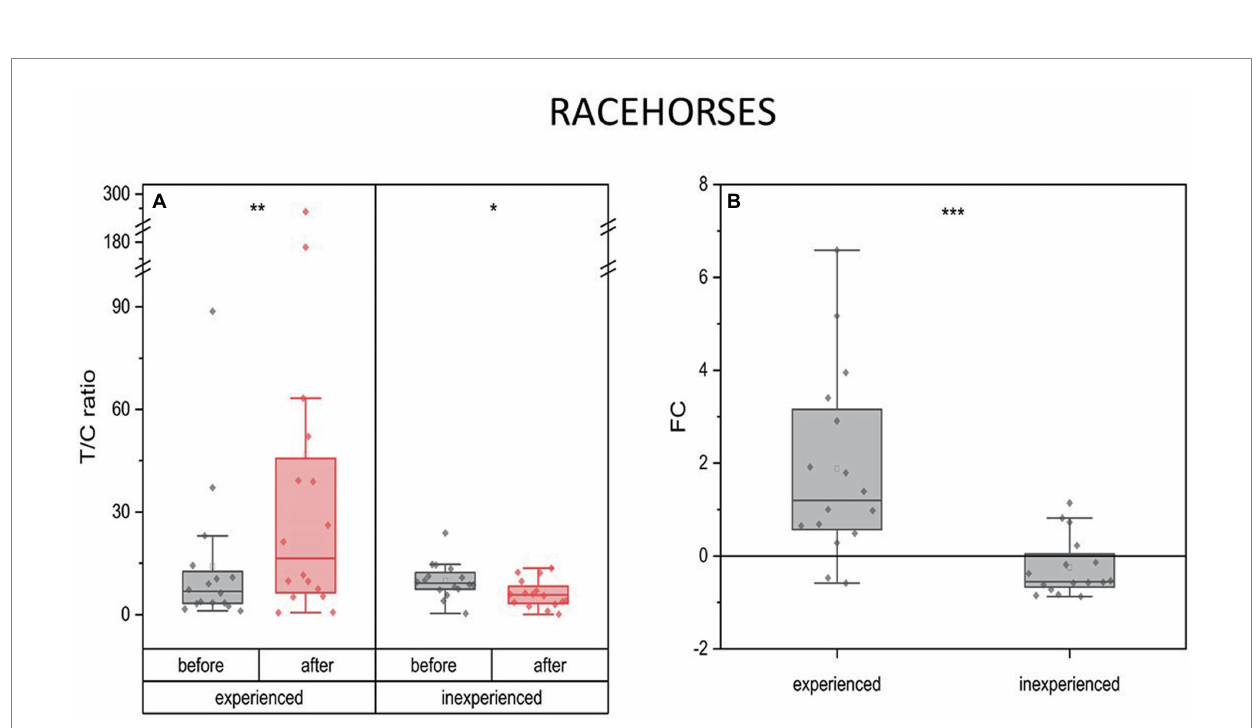
FIGURE 5 Changes in the anabolic index (T/C ratio) upon training in experienced ( n = 16) and inexperienced ( n = 16) racehorses. Box plots (IQR, mean and median; whisker range within 1,5IQR) are expressed as the ratio of hormones’ molar plasma concentration (A) and fold change (FC) (B) . Statistically significant differences are indicated by asterisks at p < 0.05 (*), p < 0.01 (**), and p < 0.001